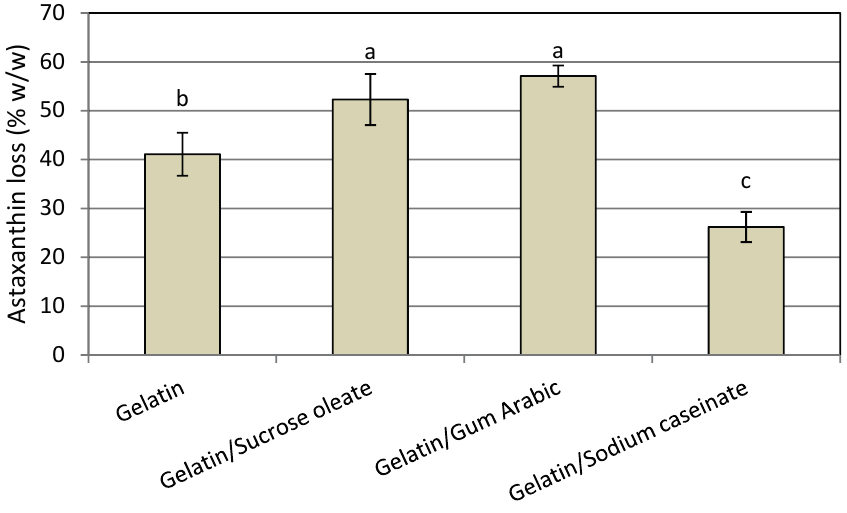
Figure 5. Mean astaxanthin loss (% w/w) of freshly prepared astaxanthin nanodispersions stabilized with different gelatin based emulsifying systems.